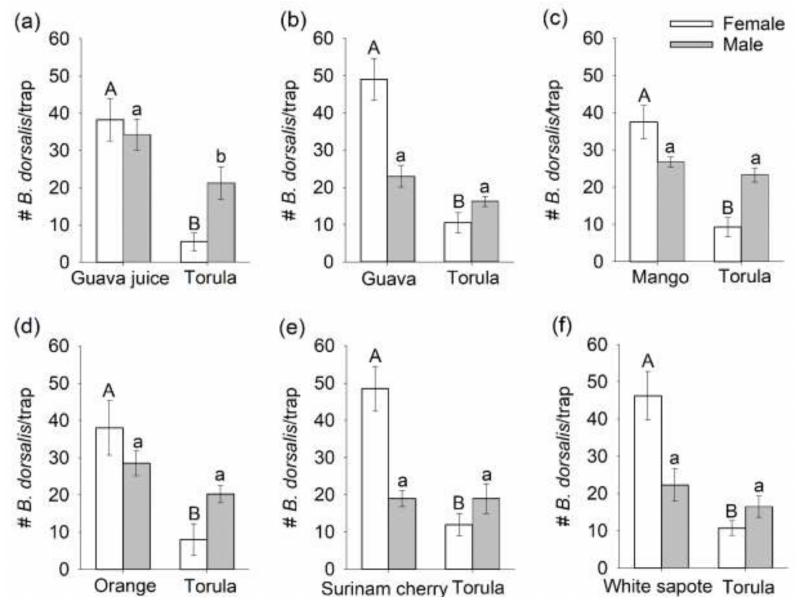
Figure 1. Mean ( ± SEM) numbers of mated male and female Bactrocera dorsalis flies captured in traps baited with torula yeast and one of the six host fruit sources (( a ) guava juice, ( b ) guava, ( c ) mango, ( d ) orange, ( e ) Surinam cherry, and ( f ) white sapote) in two-choice laboratory assays. For a given sex, different letters on bars indicate significant differences by Tukey–Kramer tests at p <